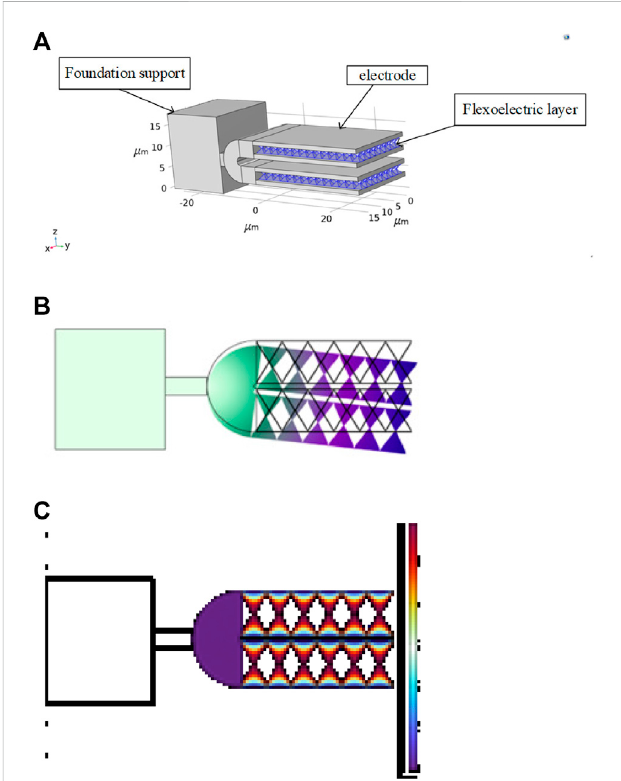
FIGURE 1 (A) The three-dimensional design diagram of the double-armed conical structure of the tuning fork; (B) The vibration diagram of the corresponding two-dimensional tuning fork structure; (C) The potential distribution diagram of the two-dimensional tuning fork double- arm vibration